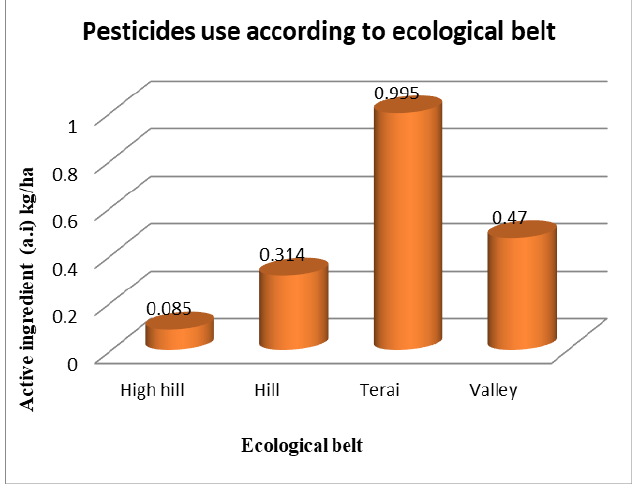
Figure 1: Pesticide use according to ecological belt (Source: Plant Protection Directorate (PPD, 2014)